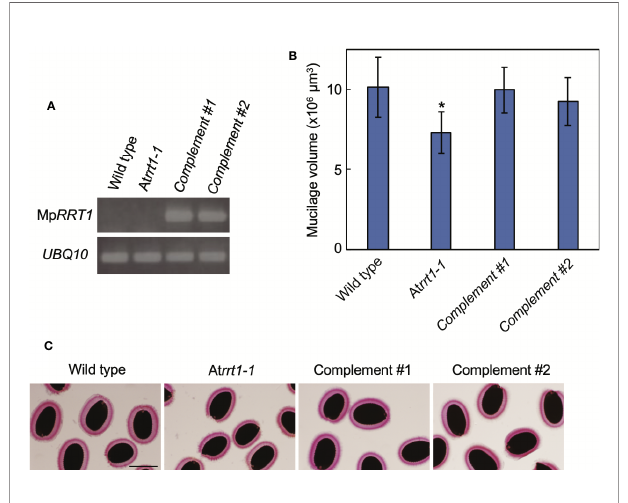
FIGURE 2 | Mp RRT1 complements the reduction in seed mucilage production in the At rrt1-1 mutant. (A) RT-PCR analysis of the Mp RRT1 transcript in the wild-type, At rrt1-1 (SALK_022924), and two complemented At rrt1-1 ( pro35S: Mp RRT1 /At rrt1-1 ) strains. UBQ10 was used as a loading control. (B) Mucilage volumes of seed coats in the wild-type, At rrt1-1 , and two complemented At rrt1-1 strains. The mucilage volumes are presented as the mean values of 20 seeds with SD. The asterisk indicates that the value was signi fi cantly different from those of the wild-type and complemented At rrt1-1 strains by Student ’ s t-test: *P < 0.05. (C) Arabidopsis seed mucilage of the wild-type, At rrt1-1 , and two complemented At rrt1-1 strains, stained with ruthenium red. Scale bar, 250 m m.